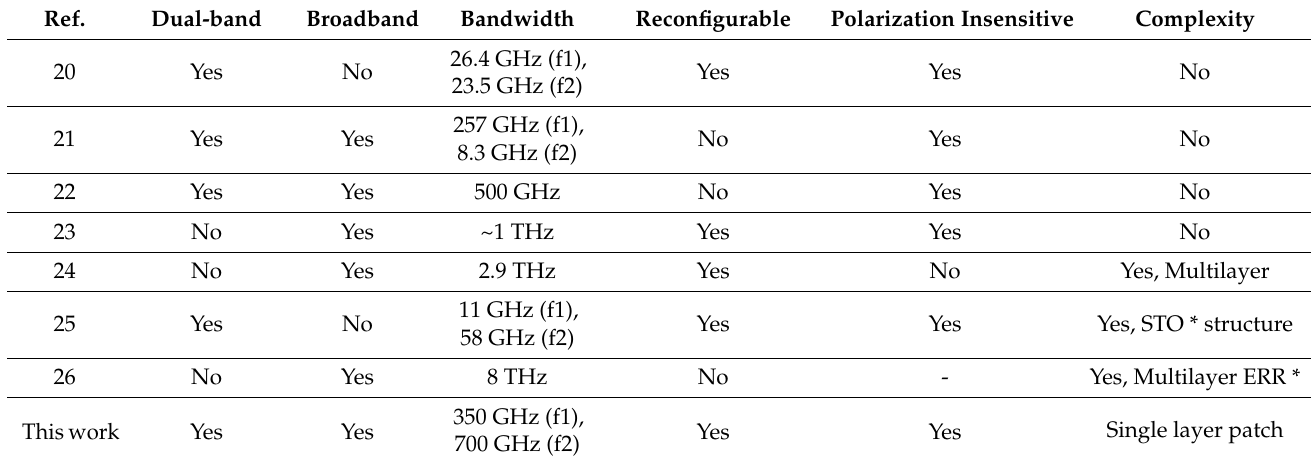
Table 1. Comparison of the obtained results with the state-of-the-art literature.